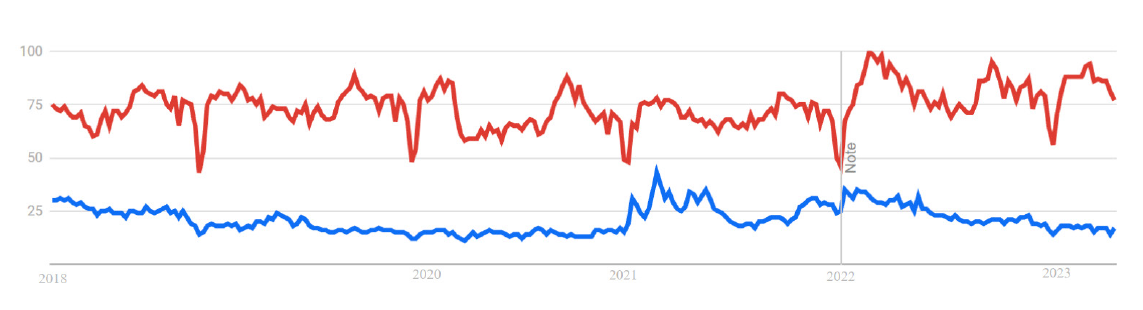
Figure 14. Google Trends results of Internet users’ queries about “blockchain” AND “accounting” in the world for